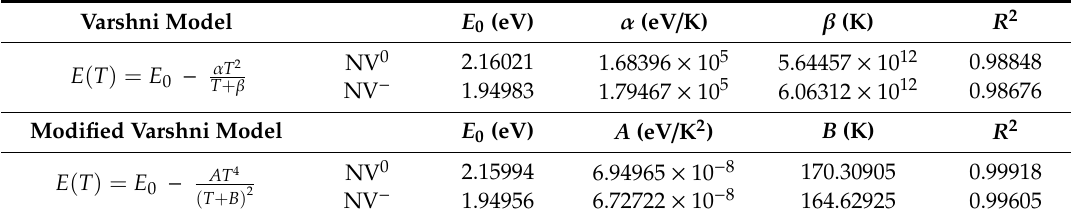
Figure 3. The ZPL position and energy level variation of ( a ) NV 0 and ( b ) NV − centers with temperature for diamond sample Sample B; the energy level variation of ( c ) NV 0 and ( d ) NV − centers with temperature for diamond sample Sample C. Table 1. A comparison of the relationship between energy levels of NV 0 and NV − centers fitted by the Varshni and modified Varshni